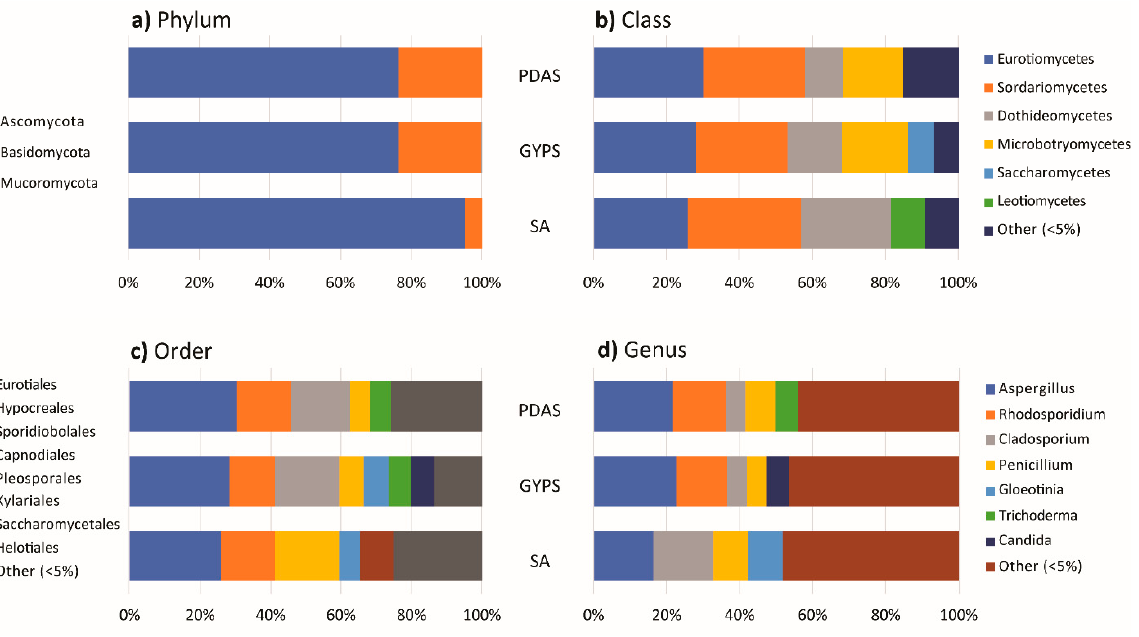
Figure 9. Bar chart showing diversity of fungi at the ( a ) phylum, ( b ) class, ( c ) order, and ( d ) genus levels isolated on seawater agar (SA), glucose-yeast extract-peptone seawater agar (GYPS), and potato dextrose seawater agar (PDAS).